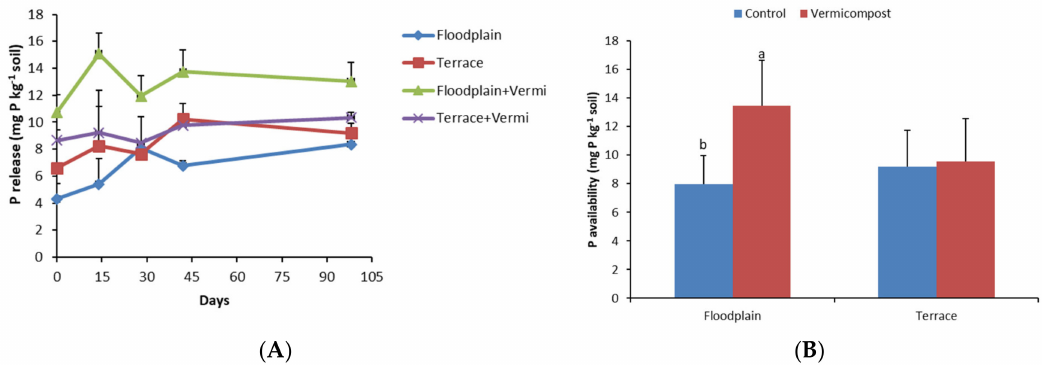
Figure 3. Trend of phosphate P (PO 43 − , HPO 42 − and/ H 2 PO 4 − ) release pattern from vermicompost- amended soils during incubation study for a period of 14 weeks ( A ); P release in two contrasting soils after 98 days ( B ) as influenced by vermicompost